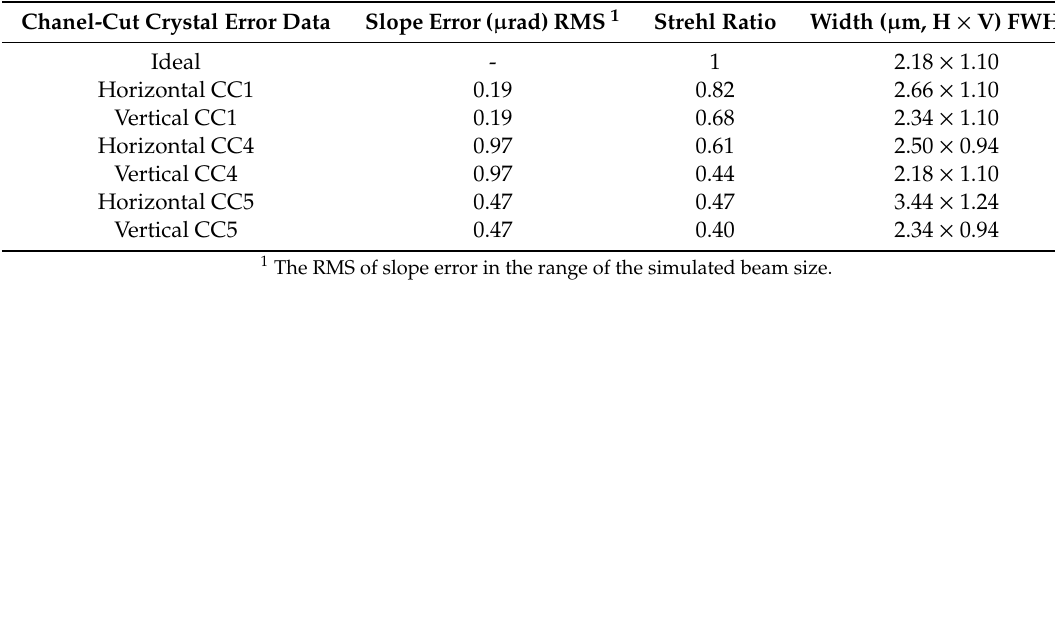
Table 5. The summarized performance of the simulated beamline with 15 µ rad acceptance